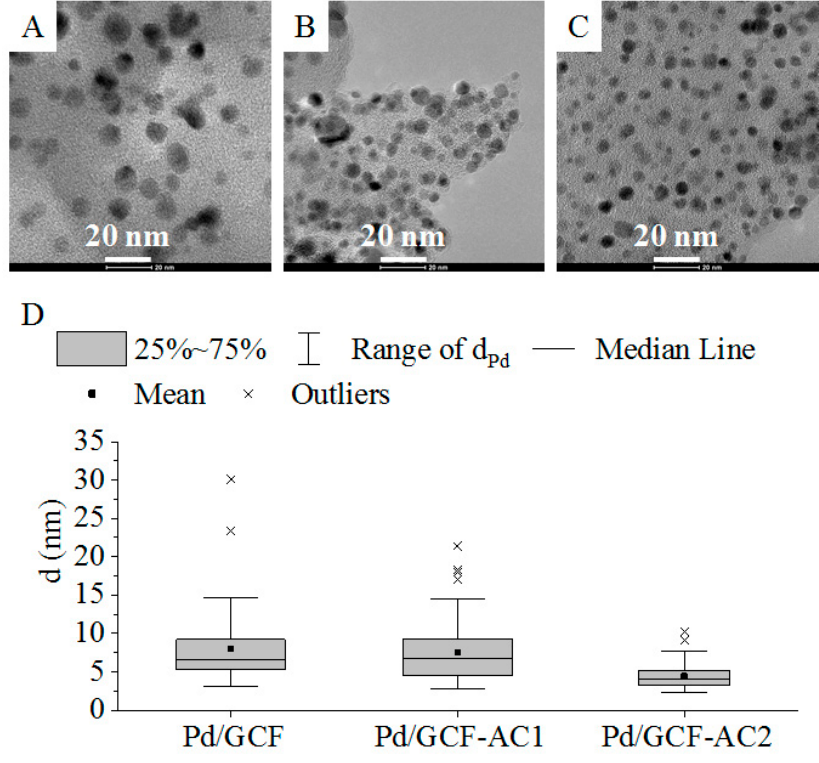
Figure 2. HRTEM pictures of sample Pd/GCF ( A ), Pd/GCF-AC1 ( B ) m and Pd/GCF-AC2 ( C ); statistics of particle size distribution ( D ).